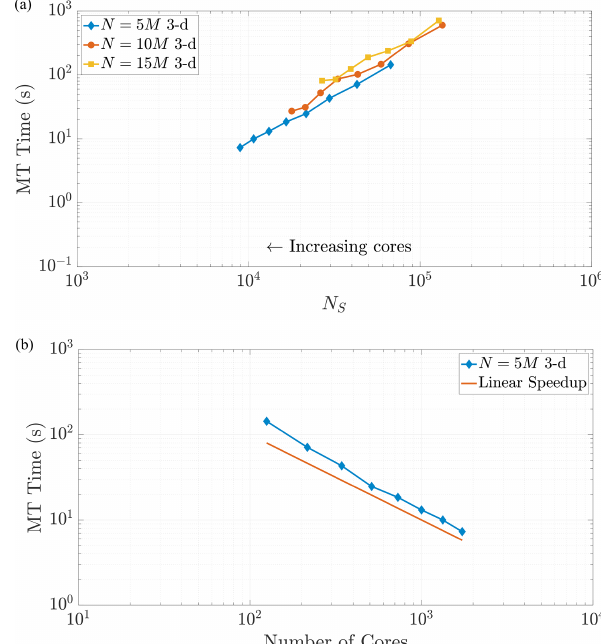
Figure 8. Varying the total particle number N directly influences the value of N S , as the rightmost side of Eq. (23) reflects. Simulations across these different values of N in 3-D exhibit common behav- ior with respect to MT run time as N S decreases, as shown in (a) . Panel (b) shows the strong scaling behavior for the 10M particle simulation for comparison to a common scaling metric. Axis lim- its are chosen for comparison with Fig. 10a. The scaling is strongly similar to the 2-D example.